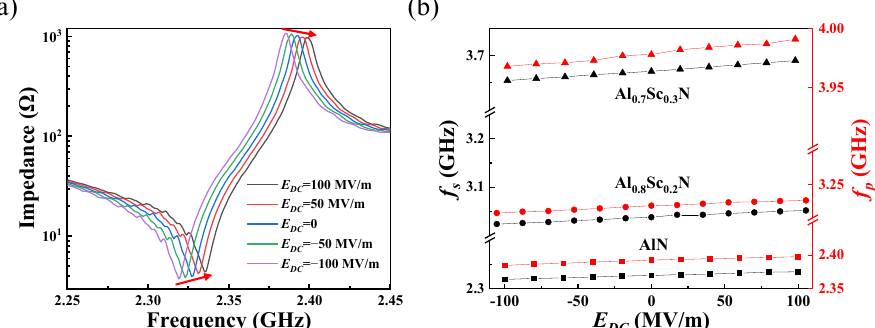
Figure 3. Resonant characteristics of FBAR under different E DC . ( a ) Measured impedance curve versus frequency at various E DC of AlN-based FBAR. ( b ) f s and f p as a function of E DC of AlN, Al 0.8 Sc 0.2 N and Al 0.7 Sc 0.3 N-based FBARs.